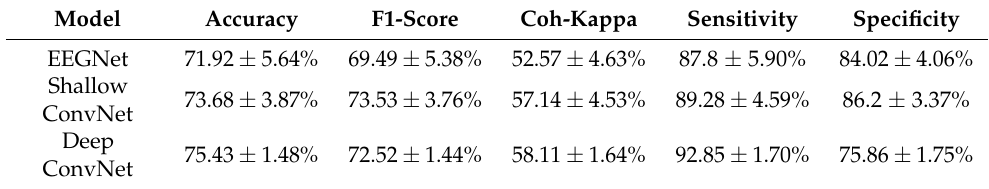
Table 4. Five-fold classification performance for transition to FOG vs. transition to voluntary stopping vs. normal